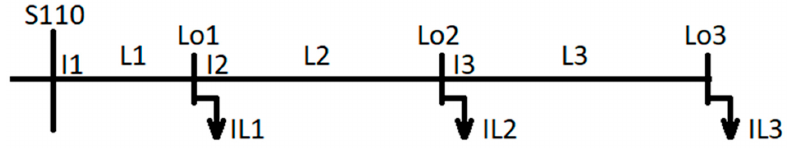
Figure 21. Exemplary load feeder.